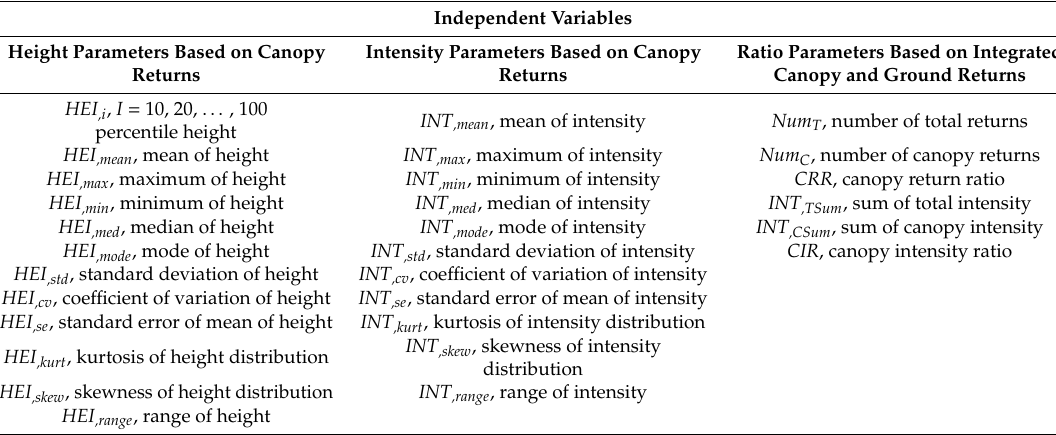
Table 1. Definition of lidar height, intensity, and ratio